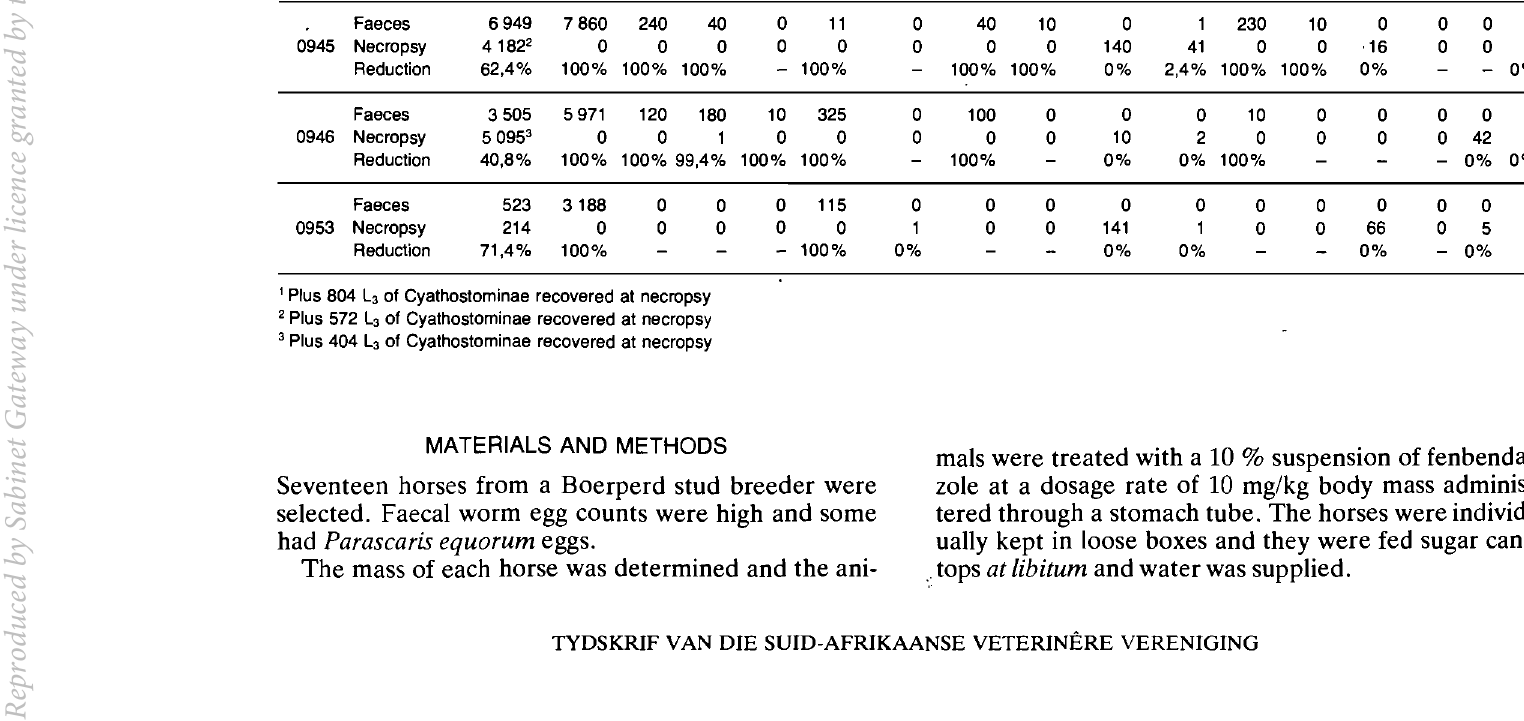
Table 2: GROUP 2: DONKEYS HAD ACCESS TO A BLOCK CONTAINING 1 mg FBZlg AND WERE FED UNTIL THEY HAD CONSUMED 10 mg/kg LIVE MASS. WORMS RECOVERED FROM FAECES AND AT